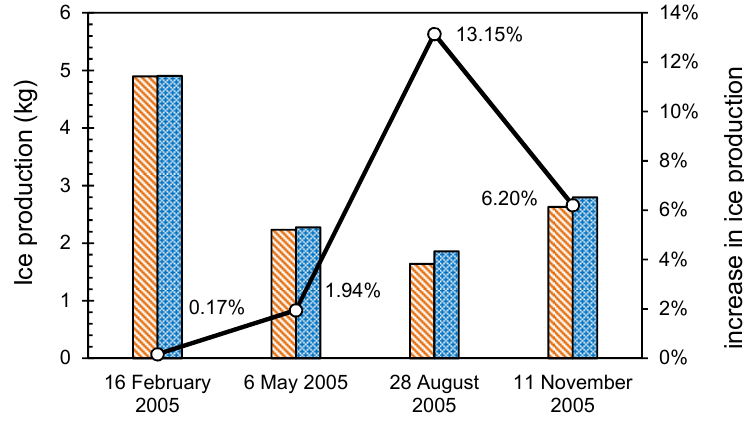
Figure 14. Ice production with the east and west wings of 1.25 m length and percentage increase compared with a linear CPC (28 August